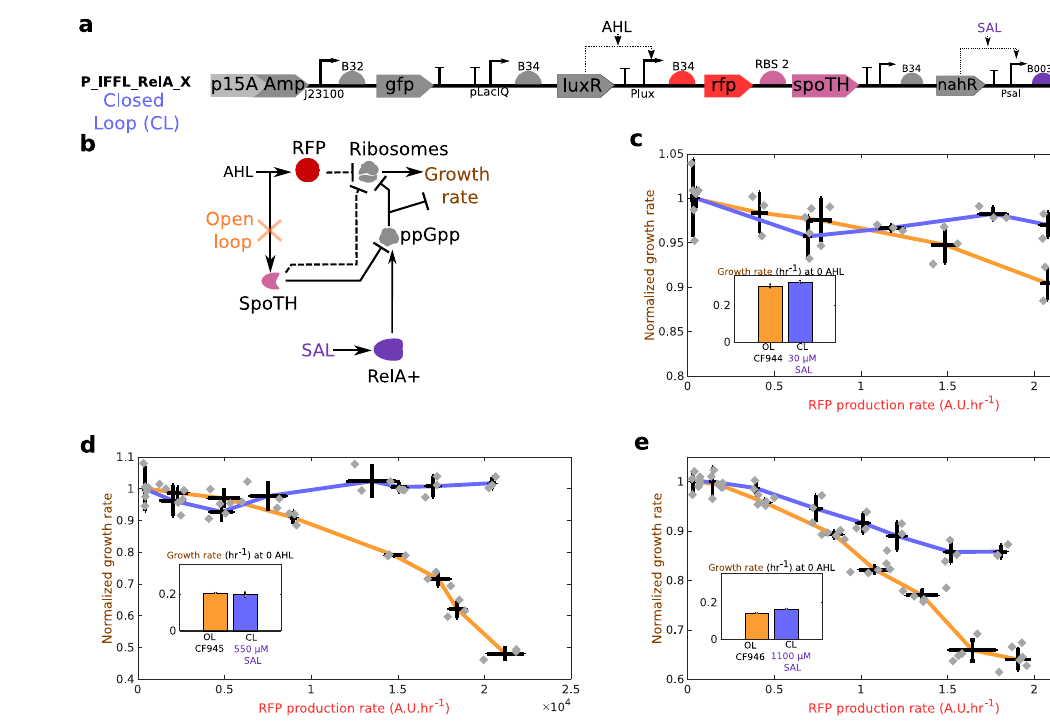
normalized by the growth rate at 0nM AHL (nominal growth rate shown in the inset)versustheRFPproductionratefortheOLinCF944( c ),CF945,( d ),andCF946 ( e ) and CL systems in TOP10. For the CL system, RelA+ expression is set to match the growth rate of the OL strain. The inset shows the nominal growth rate with no AHL induction. Data for all RBS ’ s of the CL system tested, AHL induction con- centrations used, and GFP production dataare shown in Supplementary Fig.6 and Supplementary Fig. 7. Data are shown as the mean±one standard deviation ( N =3, three biological replicates). Individual experimental values are presented as gray dots. Allexperiments wereperformedwithglycerol as the solecarbon source. The complete experimental protocol is providedinthe Materialsand Methodssection. Plasmid description, plasmid map, and essential DNA sequences are provided in Supplementary Information section Plasmid maps and DNA sequences